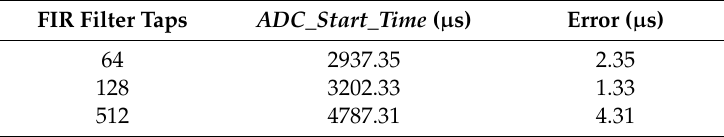
Table 3. ADC startup delay estimation for di ff erent filter taps